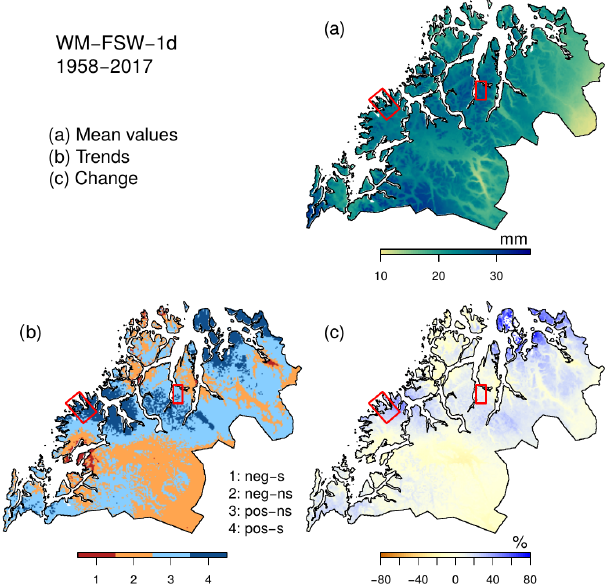
Figure 8. Maximum 1d snowfall during winter (October–April) for the period 1958–2017, based on maximum fresh snow water equiv- alent for 1d duration (WM-FSW-1d). Mean values (a) , trends (b) and changes are shown in the same way as in Fig.